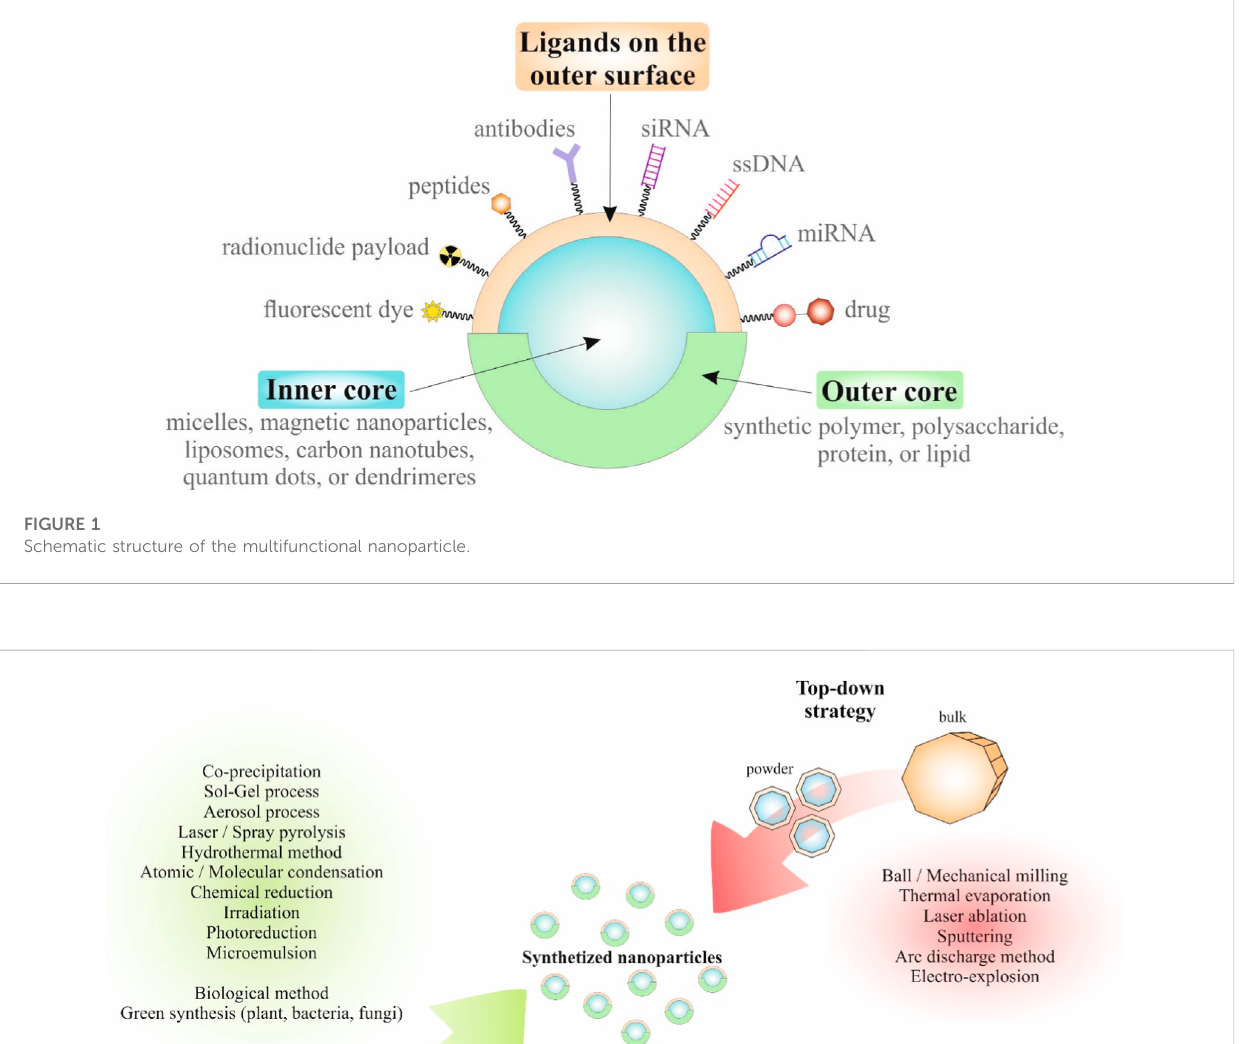
physical and chemical properties, solubility, stability, drug loading ef fi ciency, drug release, and potential distribution to different organs (Gwinn and Vallyathan, 2006; Puri et al., 2009; Singh, 2010). NPs can act as tumor detector that detects a diseased/cancer site where it accumulates and speci fi cally triggers the therapeutic activity of a circulating drug carrier. Speci fi c targeting of NPs into cancer cells is determined predominantly by ligands on their surface (Zwicke et al., 2012; Yang et al., 2022). At cancer sites, several nanodrugs act as DNA-damaging, immunostimulant, microtubule-inhibiting, or hormone agonist agents that trigger various anticancer pathways